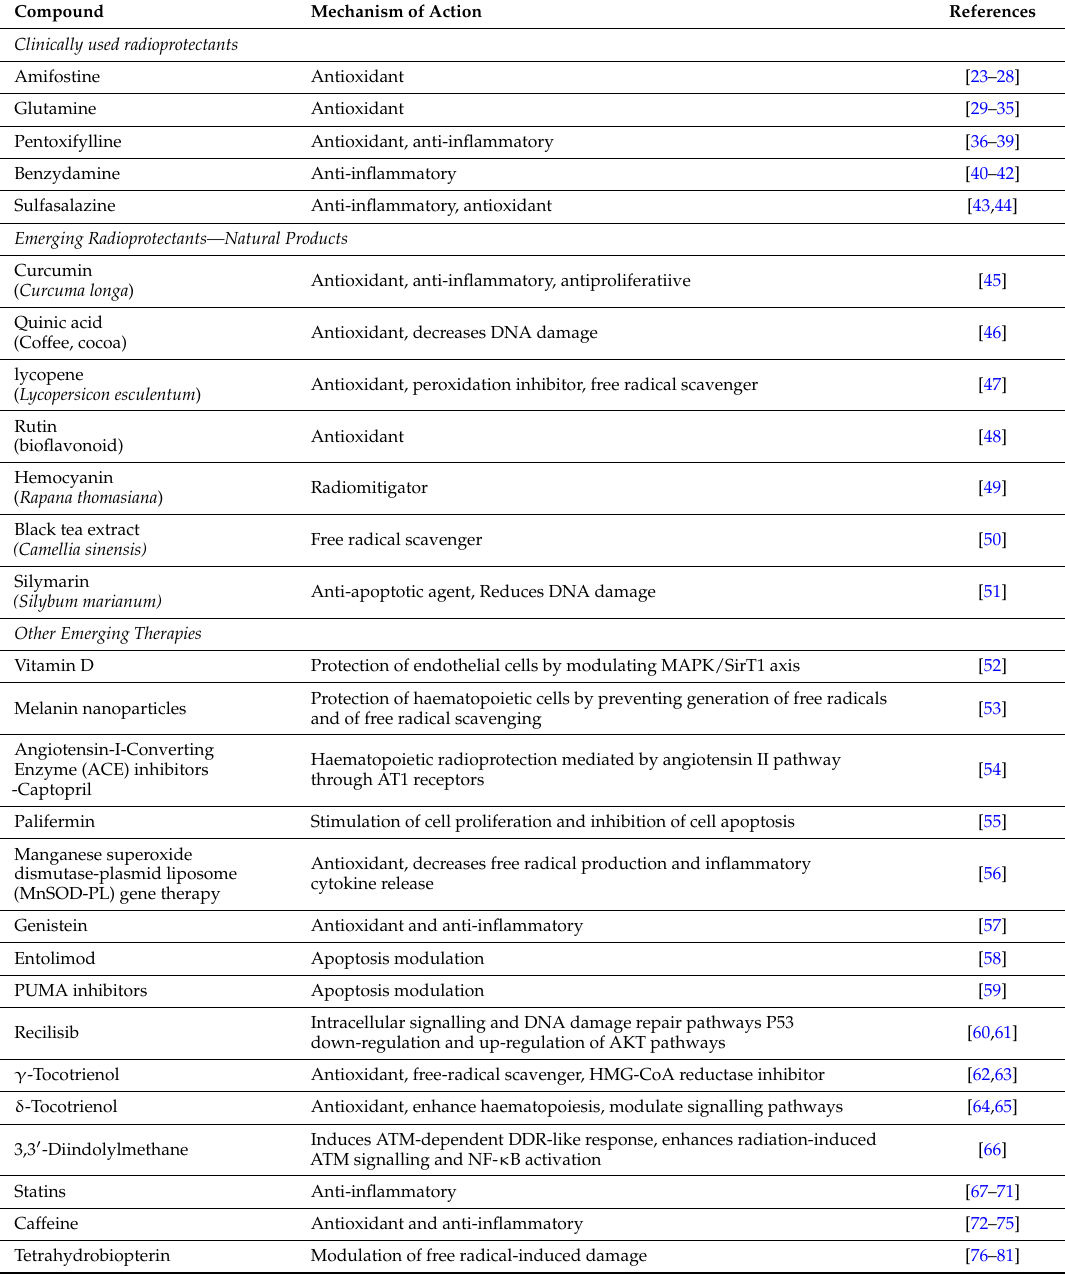
Table 2. A summary of radioprotectant